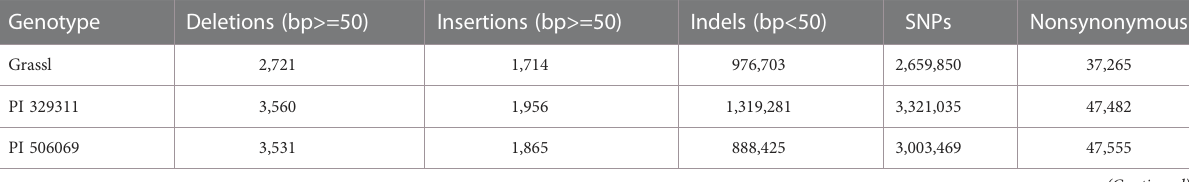
TABLE 2 Variants found in each NAM parent